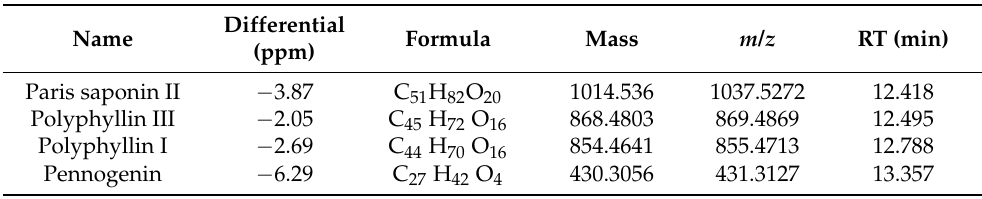
Table 4. Mass spectral characteristics and tentative identification of anticancer compounds present in PPEusing HR-LCMS in positive mode.